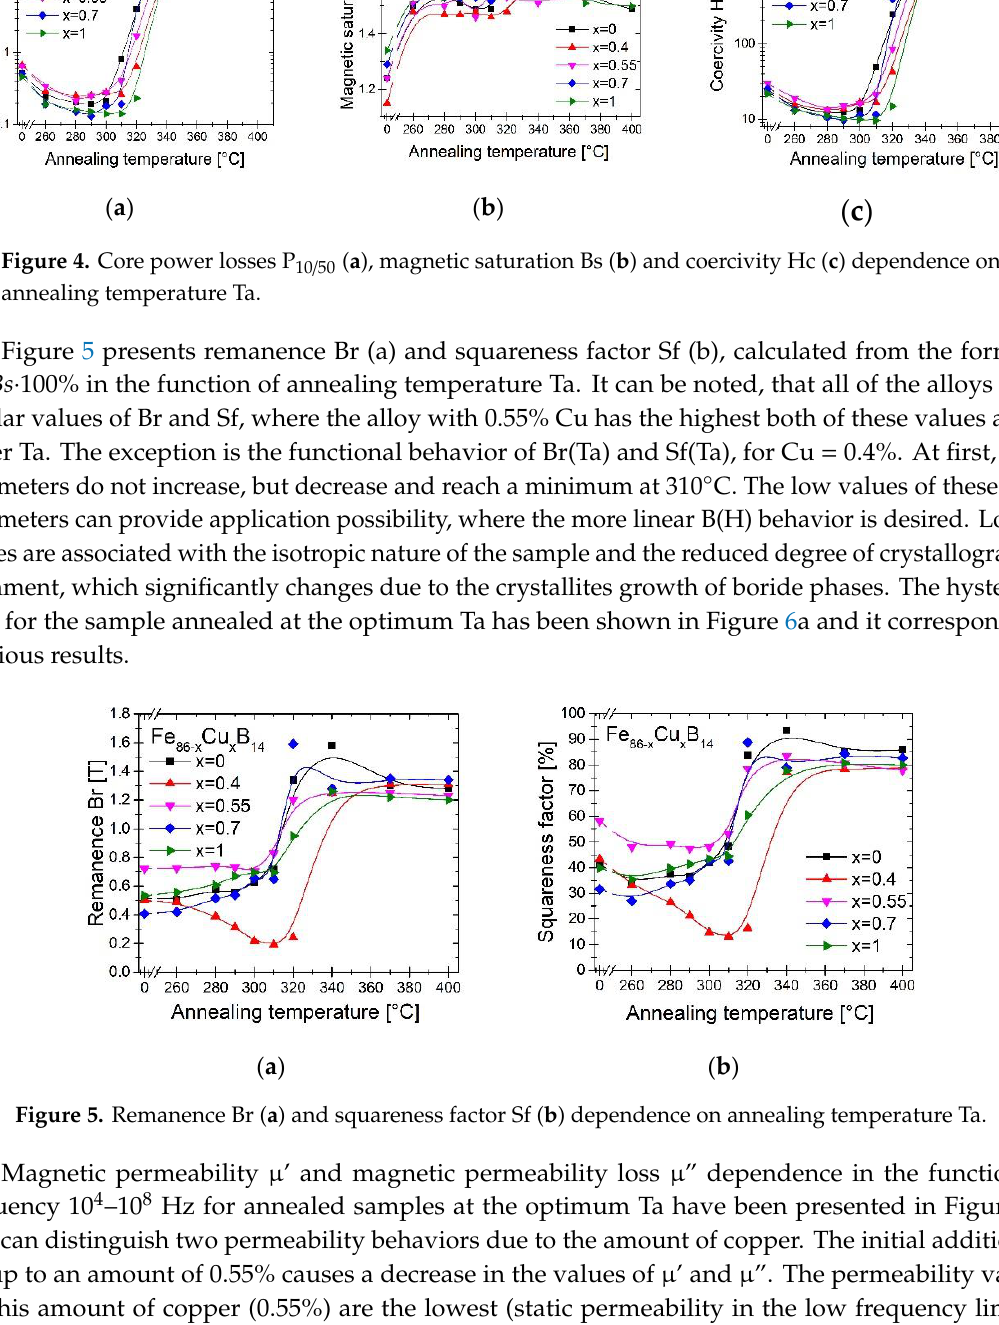
annealing temperature Ta.